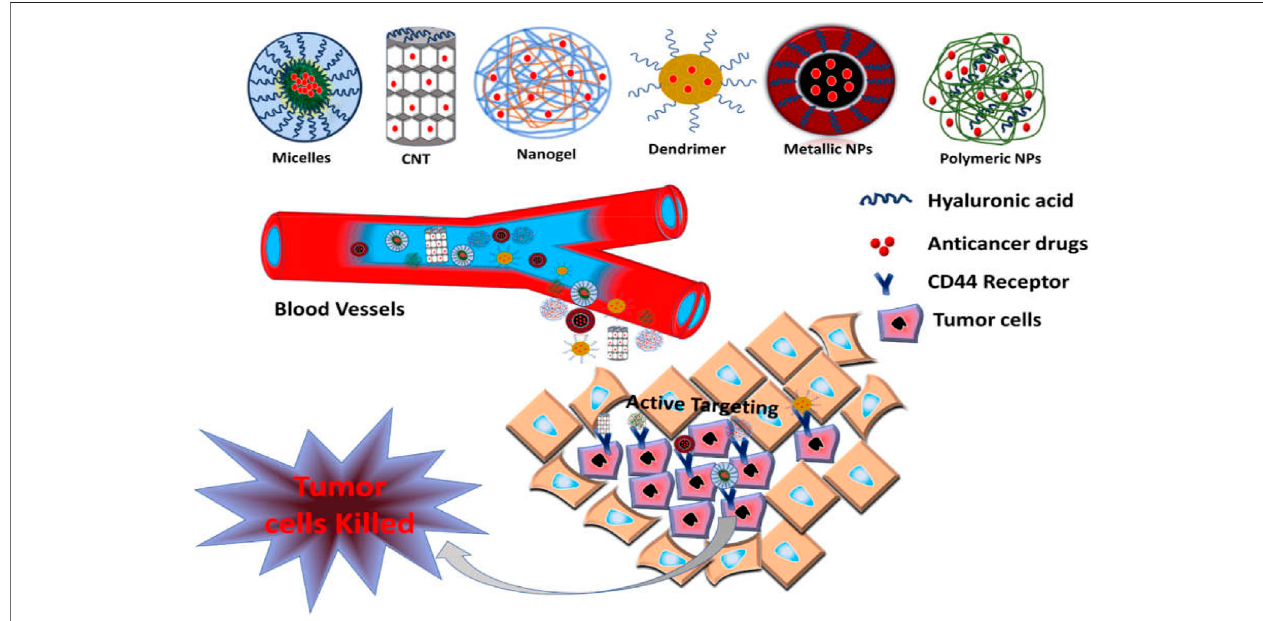
FIGURE 4 | Schematic illustration of CD44-targeted delivery of anticancer